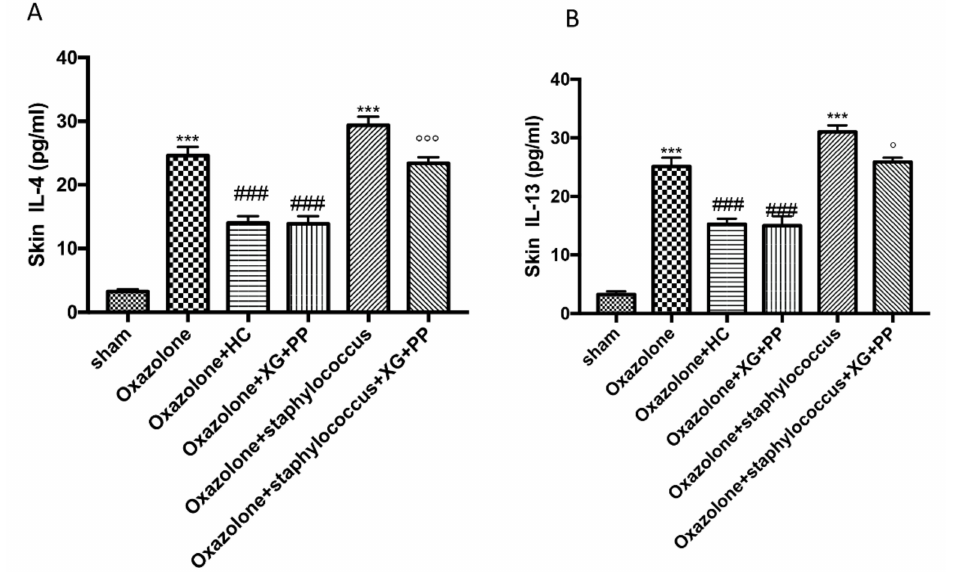
Figure 6. E ff ect of xyloglucan and pea protein on Interleukin (IL)-4 and IL-13 expressions: The levels of IL-4 ( A ) and IL-13 ( B ) were significantly increased in mice treated with oxazolone. The increases in levels of IL-4 and IL-13 were significantly attenuated in the mice receiving XG and pea protein topical administration ( A , B , respectively). *** p < 0.001 vs. sham; ### p < 0.001 vs. oxazolone; ◦◦◦ p < 0.001 and ◦ p < 0.05 vs. oxazolone +